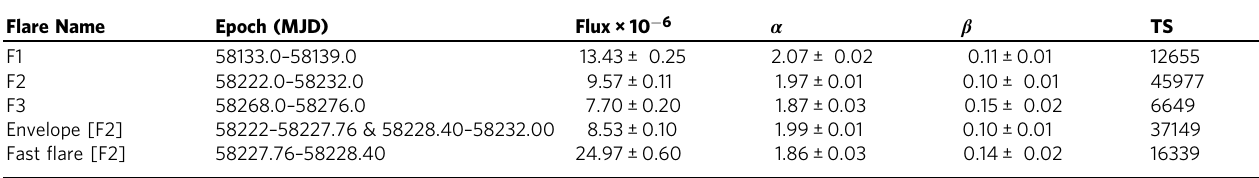
Column (1) presents the fl are name, Column (2) presents the observation duration, Column (3) presents the observed fl ux during each epoch in the units of Ph cm − 2 sec − 1 , Column (4) presents the spectral index α at E b when fi tted with logparabola model, here E b is the scale parameter, Column (5) presents the curvature parameter β when fi tted with logparabola model, Column (6) presents the test statistics (TS) of the